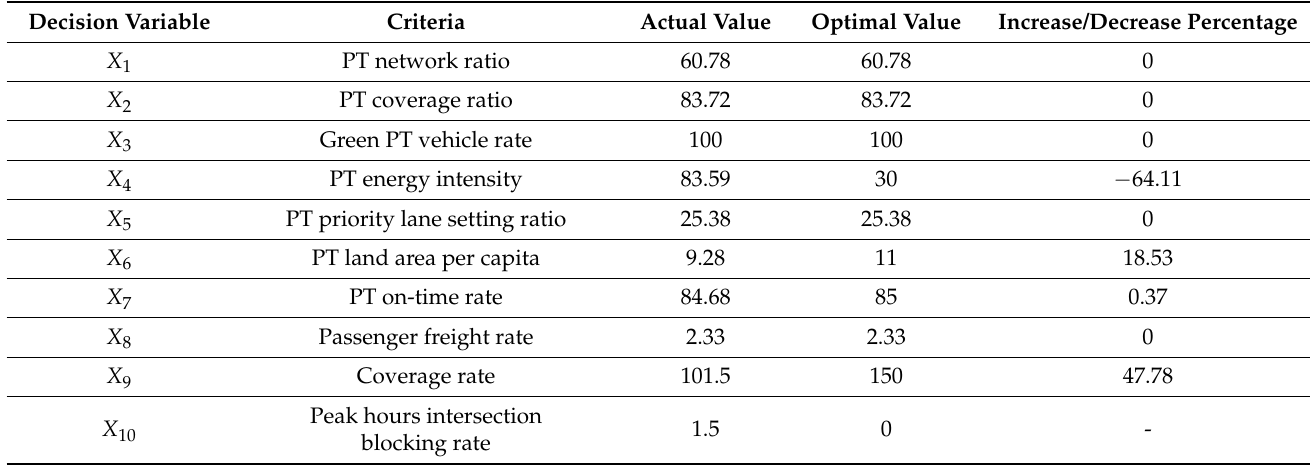
Table 6. Optimal solution for